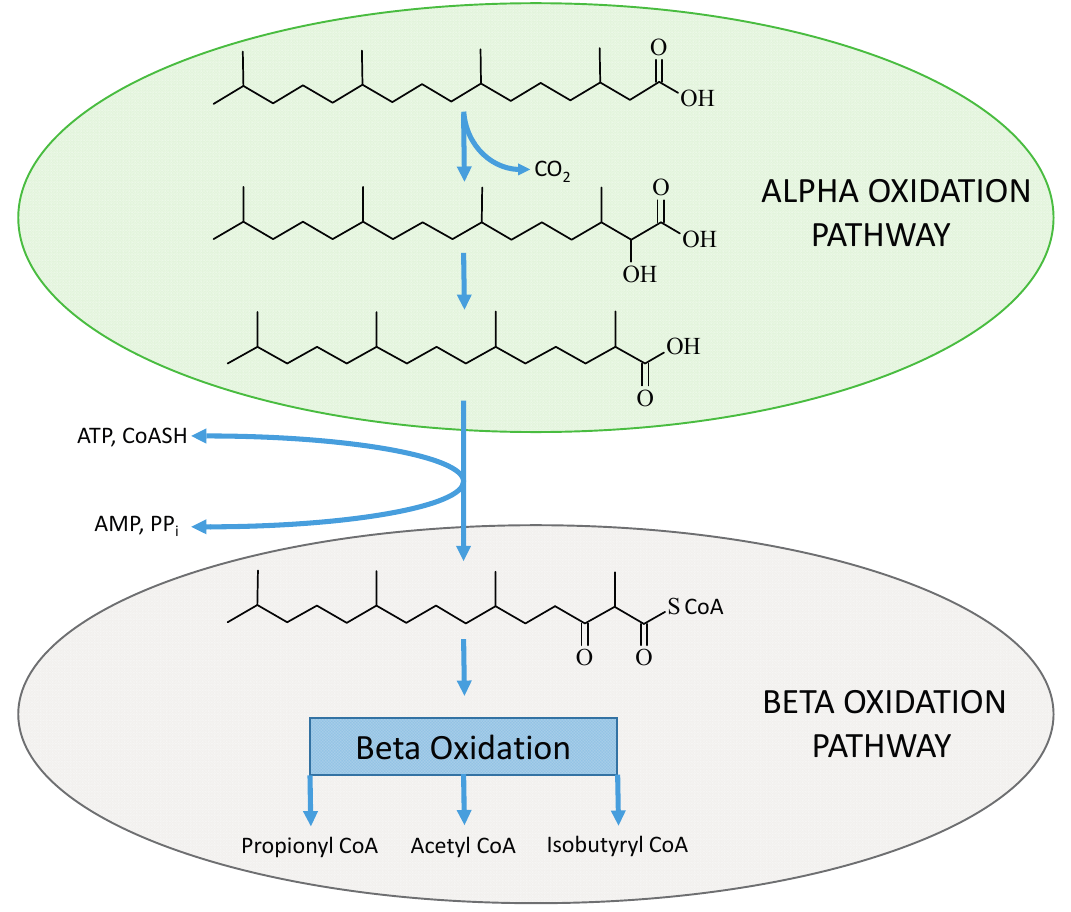
Figure 3. The α -oxidation process on the β -branched chain fatty acid (phytanic acid) to produce an α -branched chain fatty acid (pristanic acid) which then can be activated and enter the β -oxidation pathway